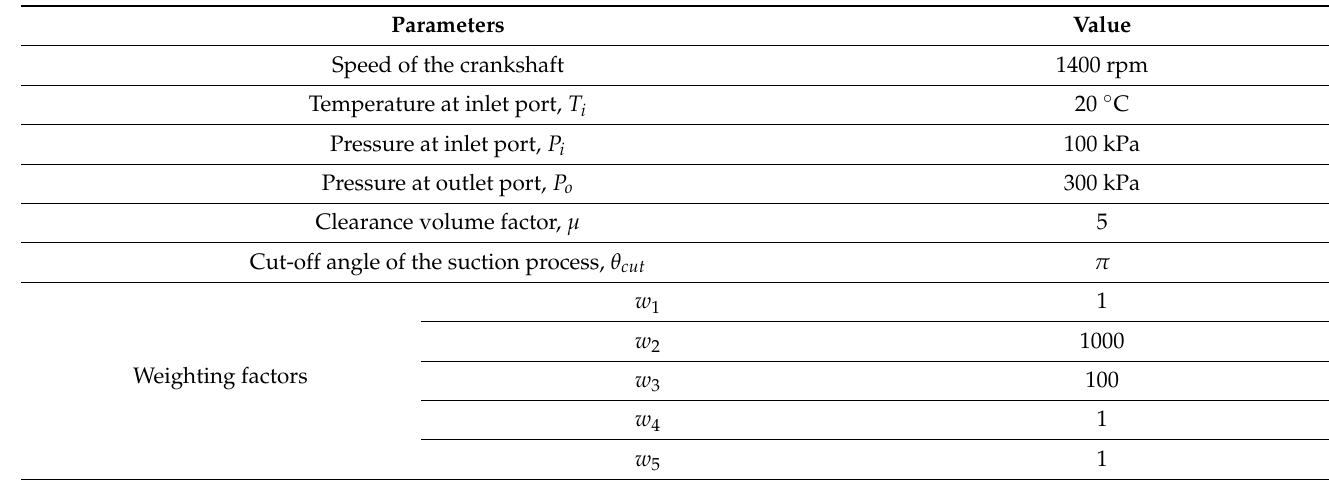
Table 2. Assumptions of the optimization process.